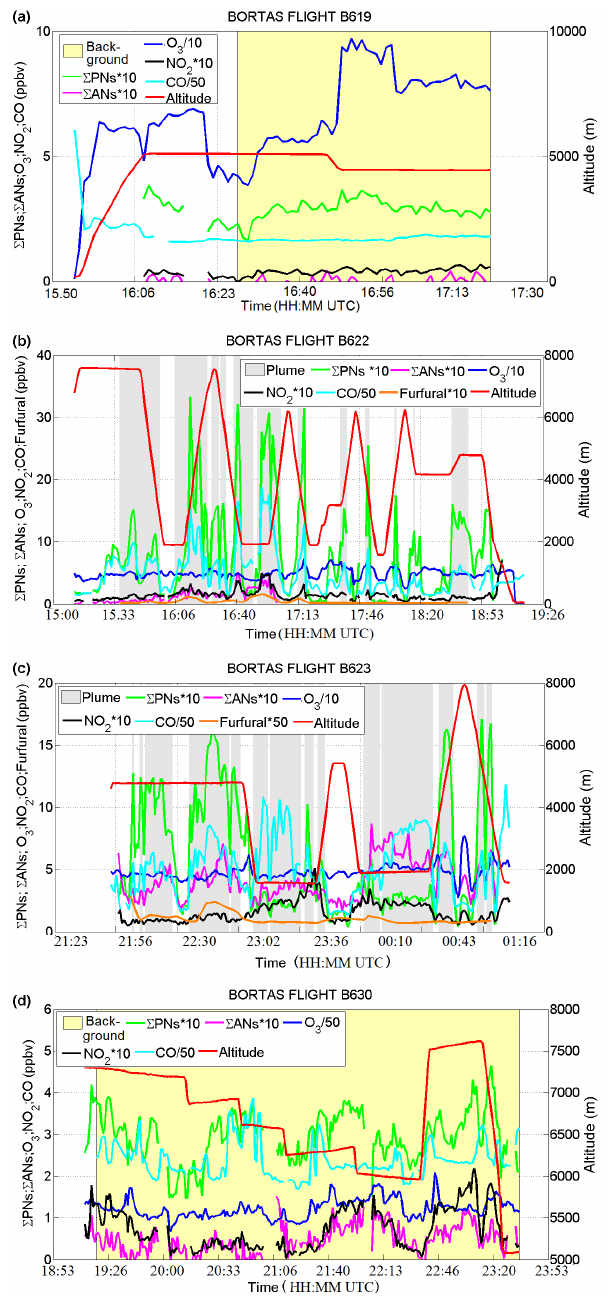
Figure 5. Time series of the P PNs, P ANs, NO 2 , O 3 , CO, fur- fural (ppbv) measured during the flights in this analysis: the flights B619 (a) and B630 (d) were background plumes, flight B622 was in part impacted by fire plume and in part by no fire (b) , and flight B623 (c) was affected by fire plume. Time is reported in Coordi- nated Universal Time (UTC).